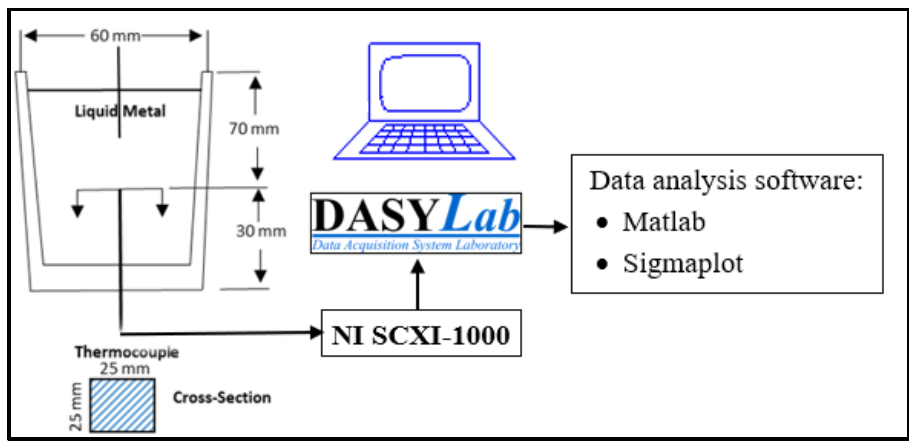
Figure 5. Schematic diagram of the thermal analysis set-up used in the present work.